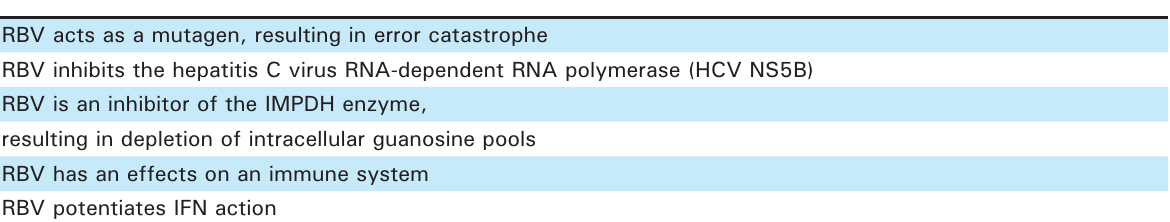
Table 2 Mechanism of action ribavirin